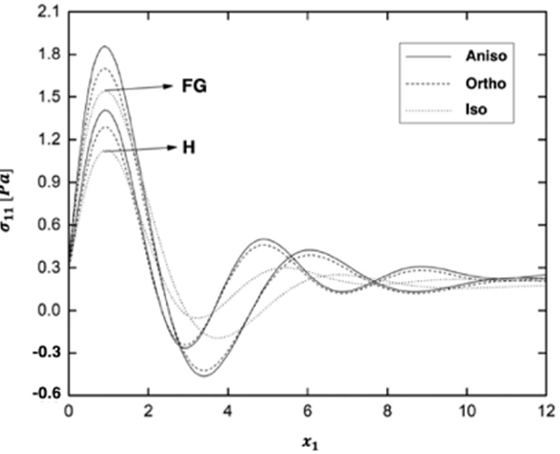
Figure 8. Variation of the thermal stress wave σ 11 along x 1 − axis in the functionally graded (FG) and homogeneous (H) fiber-reinforced plates for different materials.